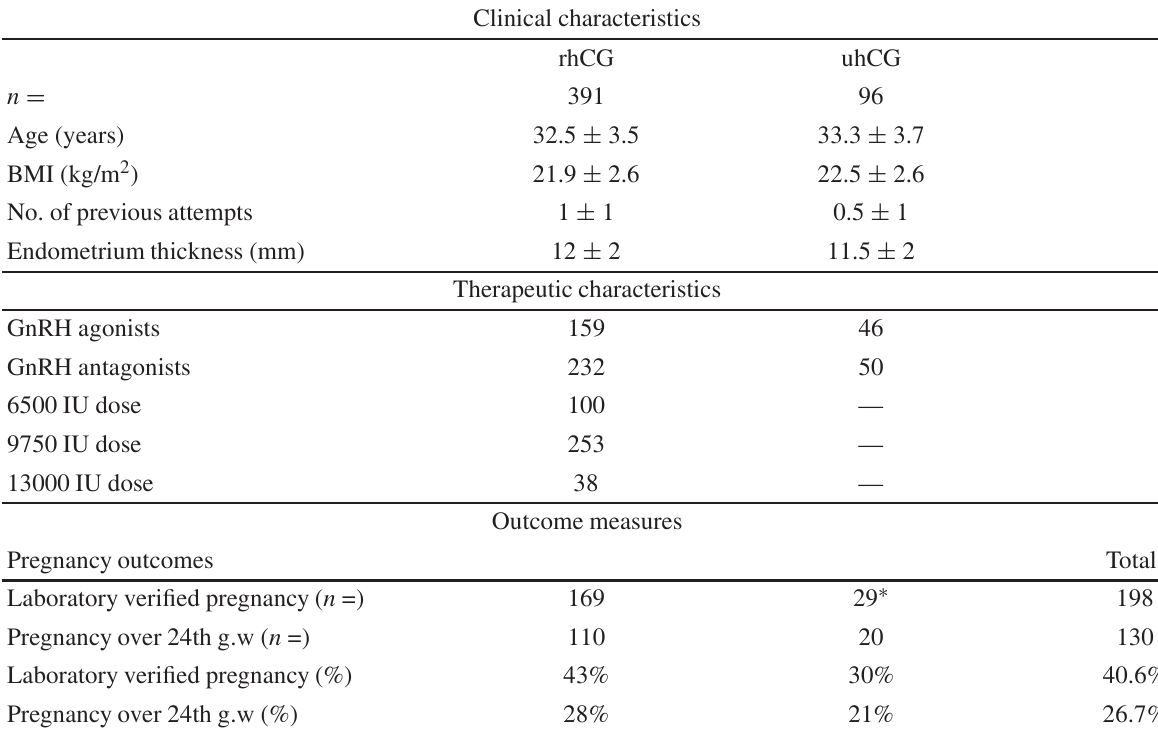
TABLE 1: Patients’ enrollment, clinical characteristics and outcomes. Abbreviations: rhCG: recombinant hu- man chorionic gonadotropin; uHCG: urinary human chorionic gonadotropin; BMI: body mass index; GnRH: gonadotrop-releasing hormone; IU: international unit; g.w: gestational